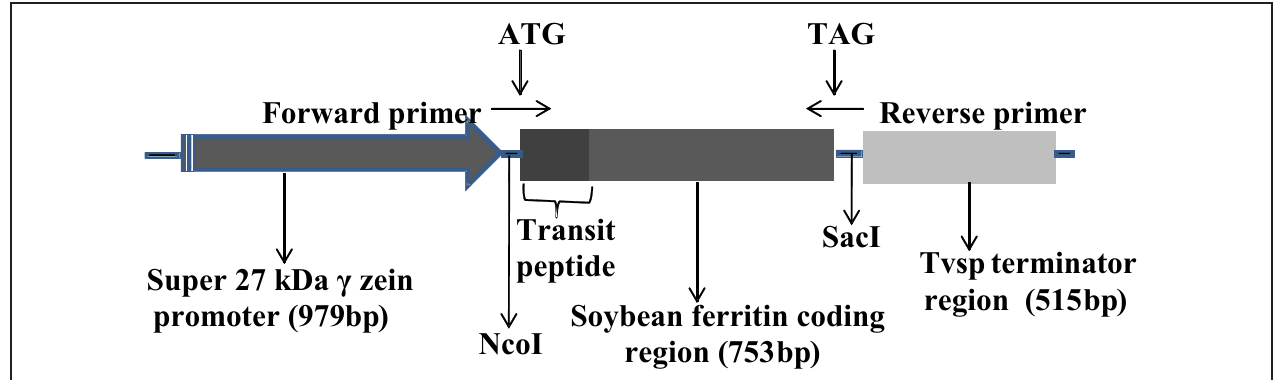
FIGURE 1 | Organization of the soybean ferritin transformation construct. The construct consisted of the super gamma zein promoter, the soybean ferritin coding sequence and the Tvsp terminator from soybean vegetative storage protein gene. The corresponding sizes for each construct component are indicated in brackets below the construct